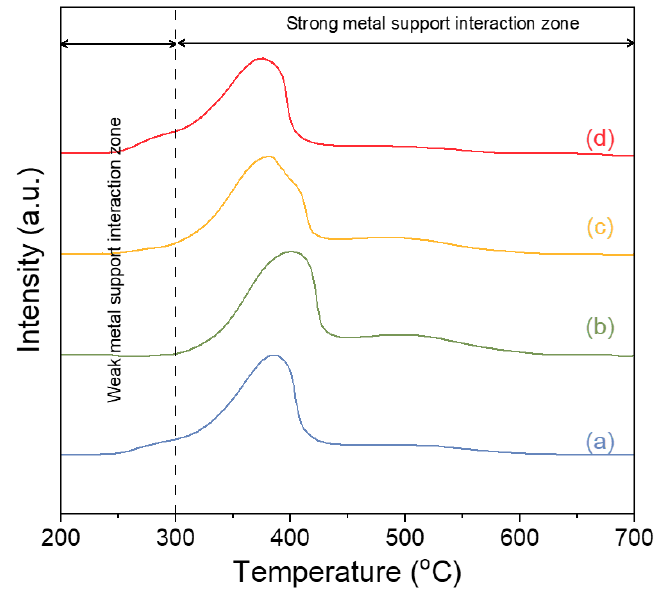
Figure 3. H 2 -TPR of the as-prepared NiO/Gd x Ce 1-x O 2- δ catalysts. (a) NiO/Gd 0.1 Ce 0.9 O 2- δ , (b) NiO/Gd 0.2 Ce 0.8 O 2- δ , (c) NiO/Gd 0.3 Ce 0.7 O 2- δ , and (d) NiO/Gd 0.4 Ce 0.6 O 2- δ .